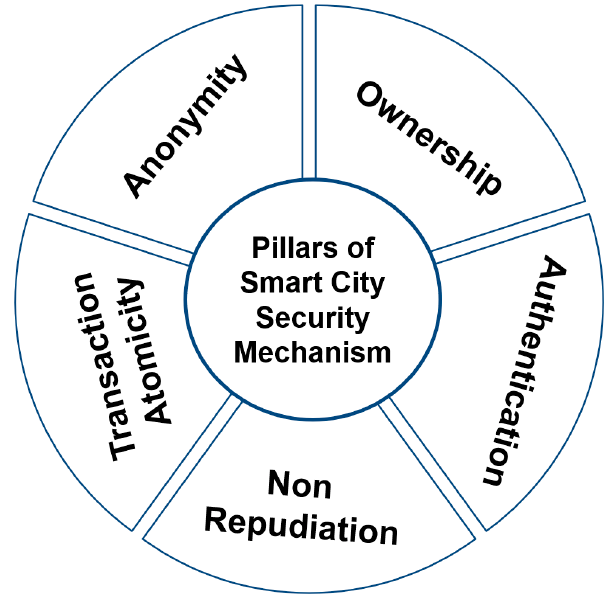
Figure 3. Pillars of smart city security mechanisms.